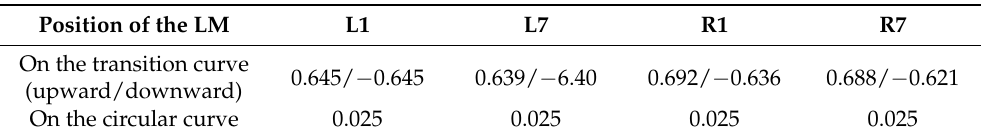
Figure 10. Deflection deformation of the LMs passing through the 650 m radius curve at the speed of 67 km/h: ( a ) L1~L7; ( b ) R1~R7. Table 4. Maximum deflection deformation amplitudes of the LMs on the 650 m radius curve (unit: mm, V = 67 km/h).